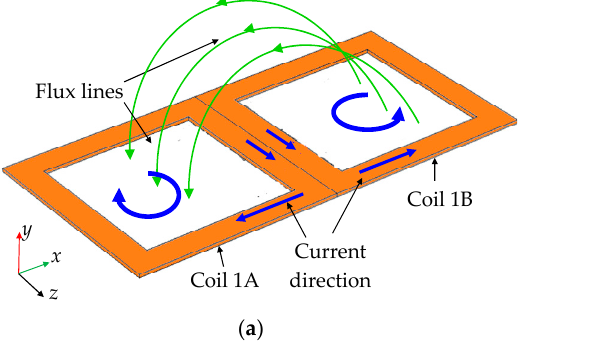
Figure 5. Magnetic flux line (in green) of DD coil with opposite mesh current directions ( a ) and identical mesh current directions ( b ).